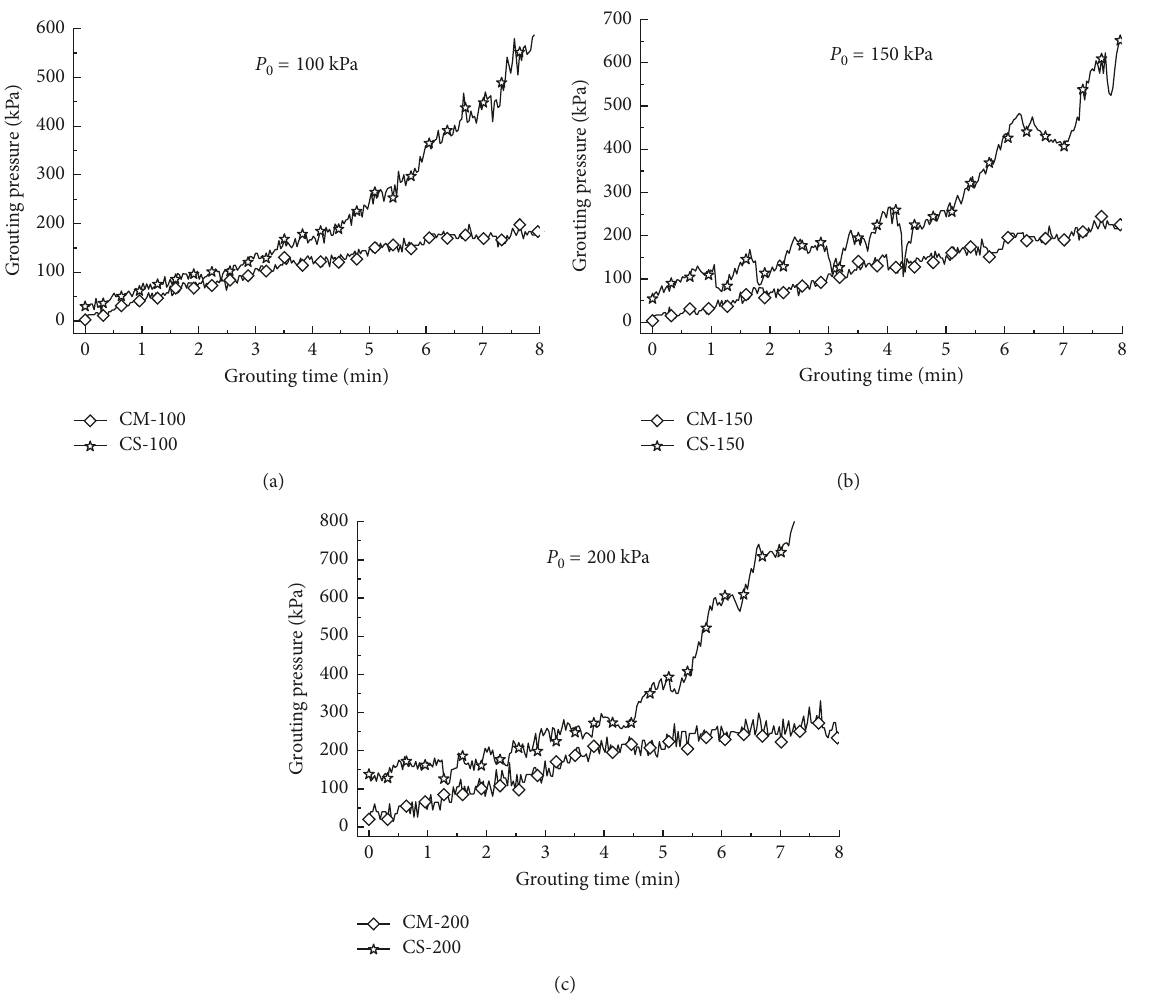
Figure 8: Grouting pressure curves: (a) initial pressure P 0 (cid:30) 100kPa, (b) initial pressure P 0 (cid:30) 150kPa, and (c) initial pressure P 0 (cid:30) 200kPa.